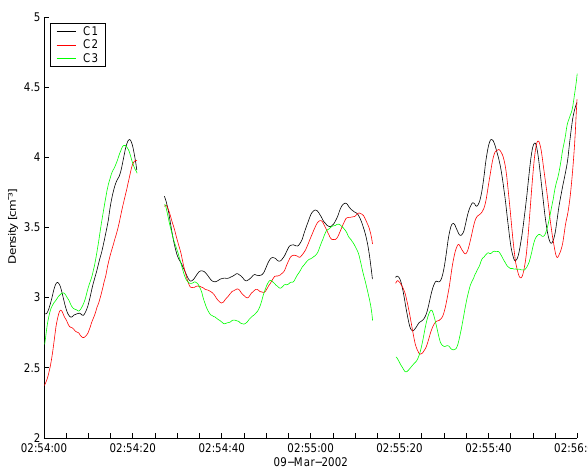
Fig. 8. Density estimates from EFW spacecraft potential measure- ments (see Pedersen et al., 2001, for a general description of the method). The data gaps are due to instrumental interference from WHISPER. For example, at 02:55:40 UT, C3 measures a differ- ent density compared to C1 and C2. This implies a local density gradient of 25% on the length scale of the spacecraft separation ∼ 50km (2 ρ p